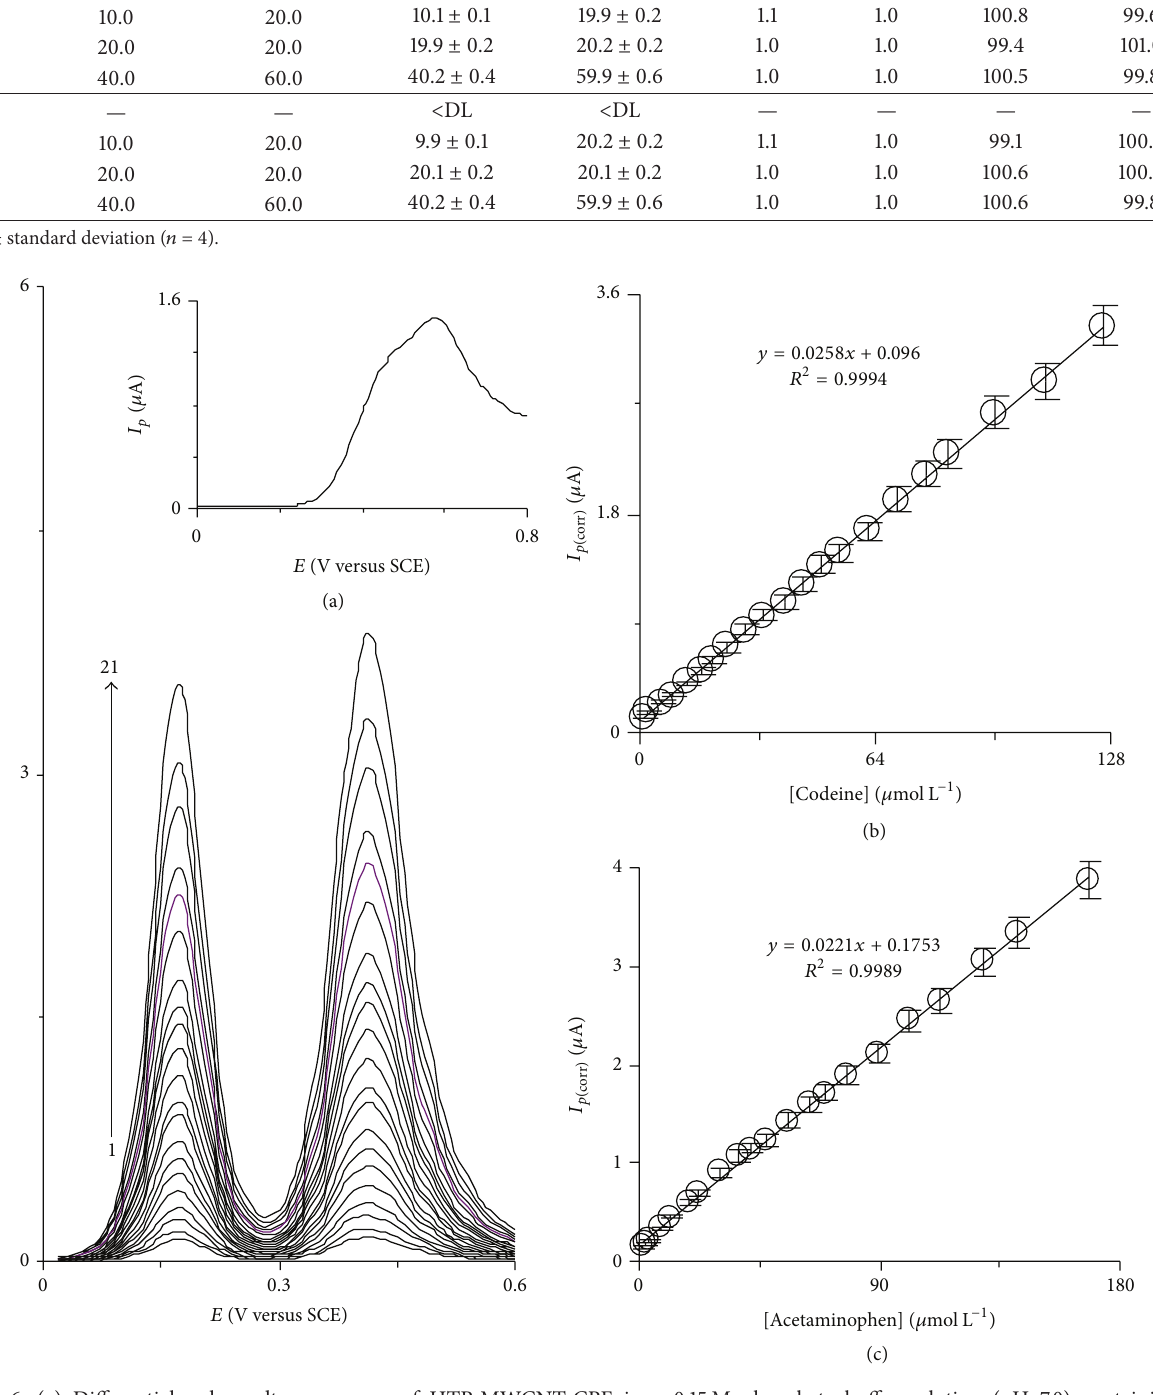
Figure 6: (a) Differential pulse voltammograms of HTP-MWCNT-CPE in a 0.15M phosphate buffer solution (pH 7.0) containing different concentrations of codeine and acetaminophen. The numbers 1–21 correspond to 1.3–168.2 𝜇 M of codeine and 0.95–125.8 𝜇 M of acetaminophen. Inset shows differential pulse voltammogram of a mixed solution of 50.0 𝜇 M of codeine and 110.0 𝜇 M of acetaminophen at CPE. (b) and (c) show the plot of the corrected electrochemical peak currents as a function of codeine and acetaminophen concentrations in the range 1.3–168.2 𝜇 M and 0.95–125.8 𝜇 M,